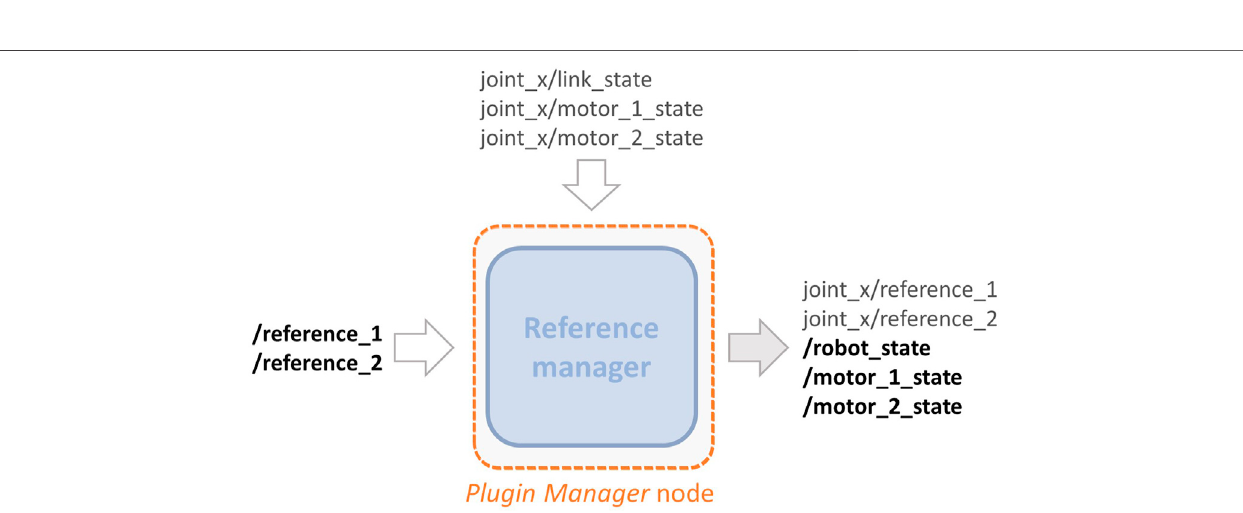
Frontiers in Robotics and AI |